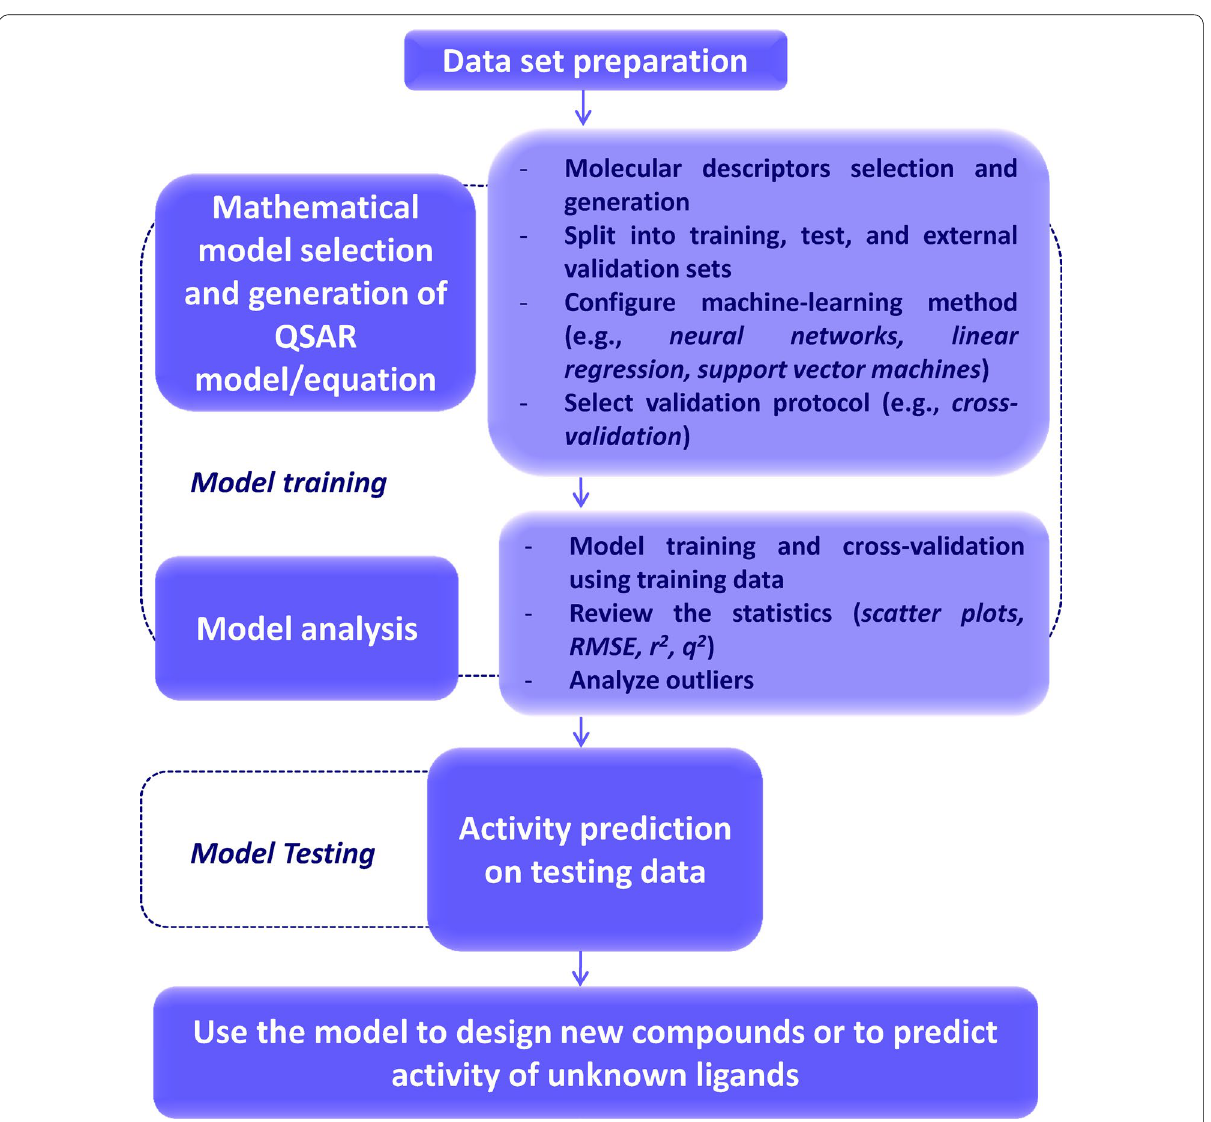
Fig. 4 Schematic representation of the QSAR